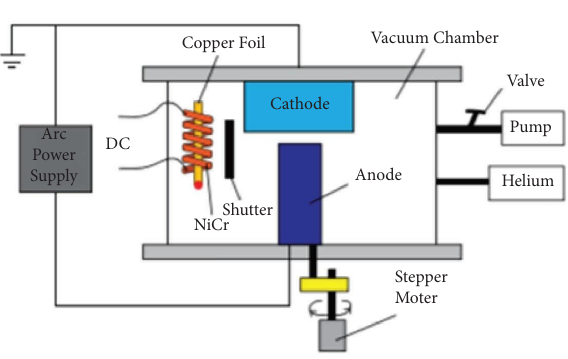
Figure 10: Arc discharge method [55].